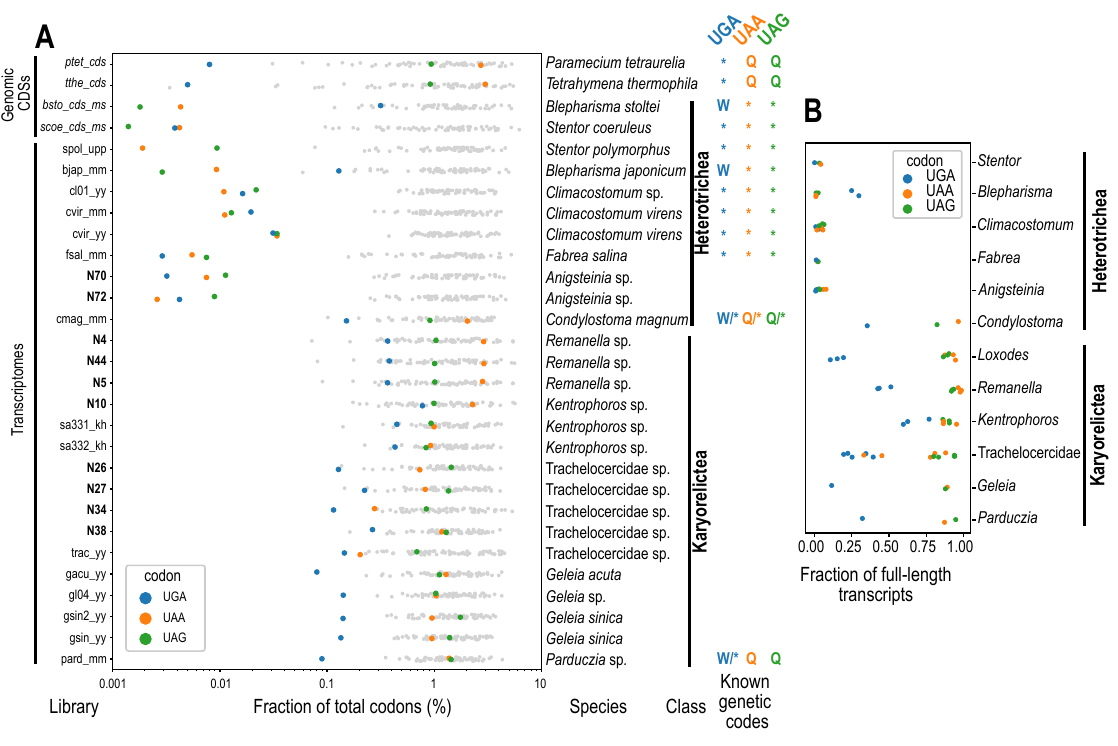
Figure 1 . ( A ) Codon frequencies of canonical stop codons (UGA: blue, UAA: orange, UAG: green) and other codons (gray) in conserved protein domains found by hmmscan search in six-frame translations of transcriptome assemblies (Table_S1.xlsx in [22]) or genomic CDSs (Table_S2.xlsx in [22]) vs. Pfam. Names of libraries from this study are highlighted in bold. Assignments of canonical stops for organisms with known genetic codes follow ref. [10]. ( B ) Fraction of full-length transcripts that have at least one canonical stop codon in the putative coding region, grouped by genus (except Trachelocercidae, where classification was